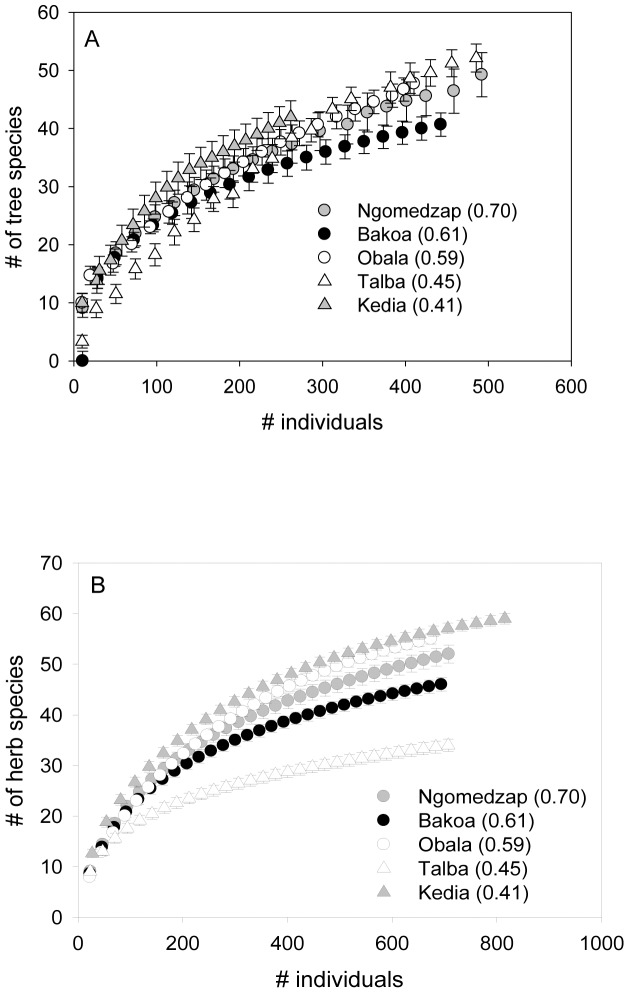
Species accumulation curves for trees (a) and herb species (b) in cocoa agroforests in relation to shade index.Error bars show 95% confidence intervals and non-overlapping bars show significant differences between shade indexes. Figures in parentheses are average values of the shade index for each region.